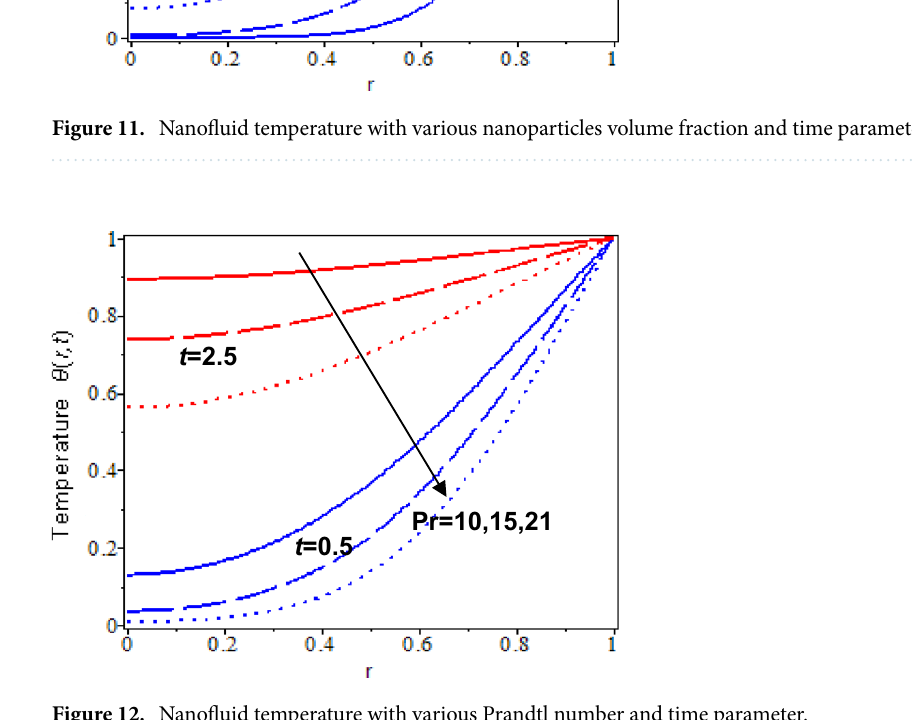
Figure 12. Nanofluid temperature with various Prandtl number and time